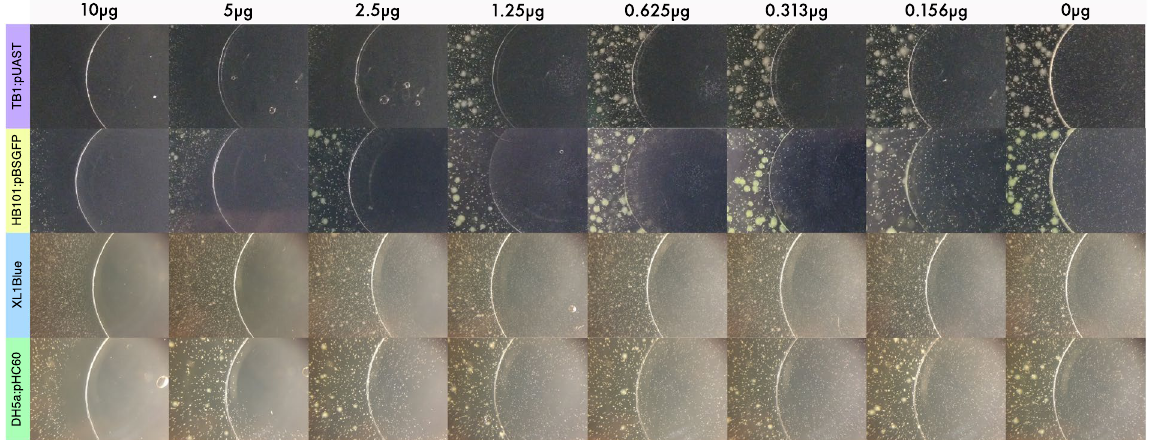
Figure 2. Determination of the amount of antibiotic in the agar diffusion assay. The mass of antibiotic applied to each coverslip is indicated at the top of each column. The top two rows (TB1 and HB101 strains) used tetracycline coverslips while the bottom two rows (XL1Blue and DH5 α ) used ampicillin coverslips. See Fig. 1 to identify colonies.